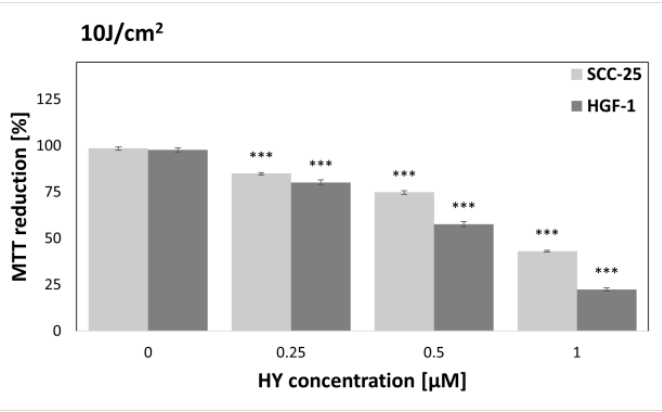
Figure 6. MTT reduction in the SCC-25 and HGF-1 lines for different HY concentrations: 0 µ M, 0.25 µ M, 0.5 µ M, and 1 µ M and light dose 5 J/cm 2 . The values represent the means ± SE. *** p < 0.01.